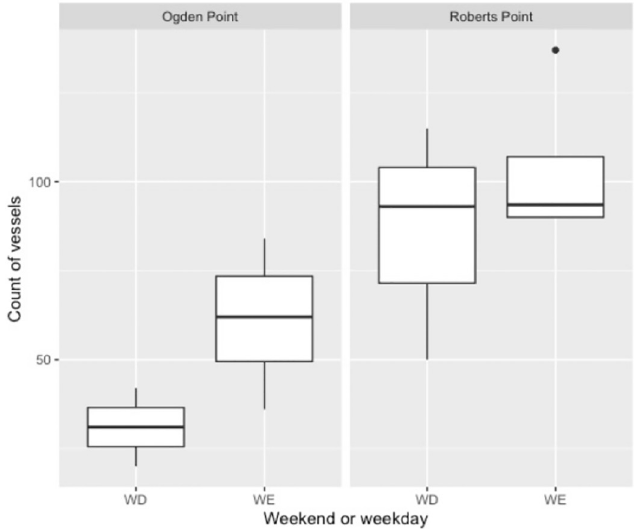
Fig 5. Distribution of daily vessel counts by day of week (weekend vs. weekday) and location, Ogden Point (VHMBS) and Roberts Point (SHMBS), Greater Victoria, Canada.